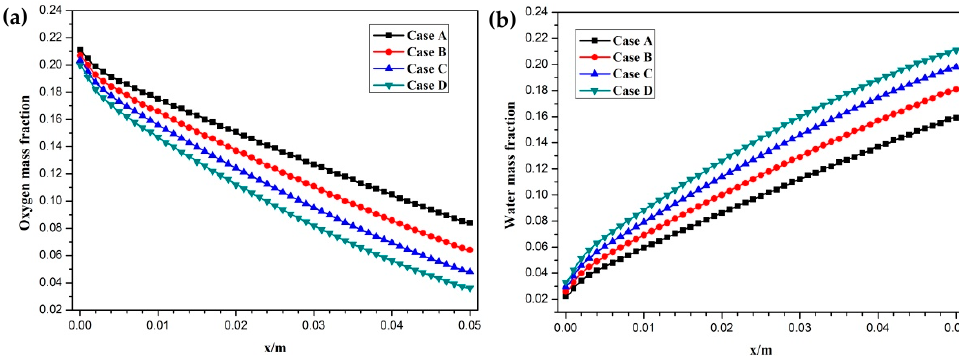
Figure 8. Species mass fraction profile distributions at y = 0.001 m (Case A: DL = 5; Case B: DL = 7; Case C: DL = 9; Case D: DL = 11): ( a ) oxygen mass fraction; ( b ) water mass fraction.